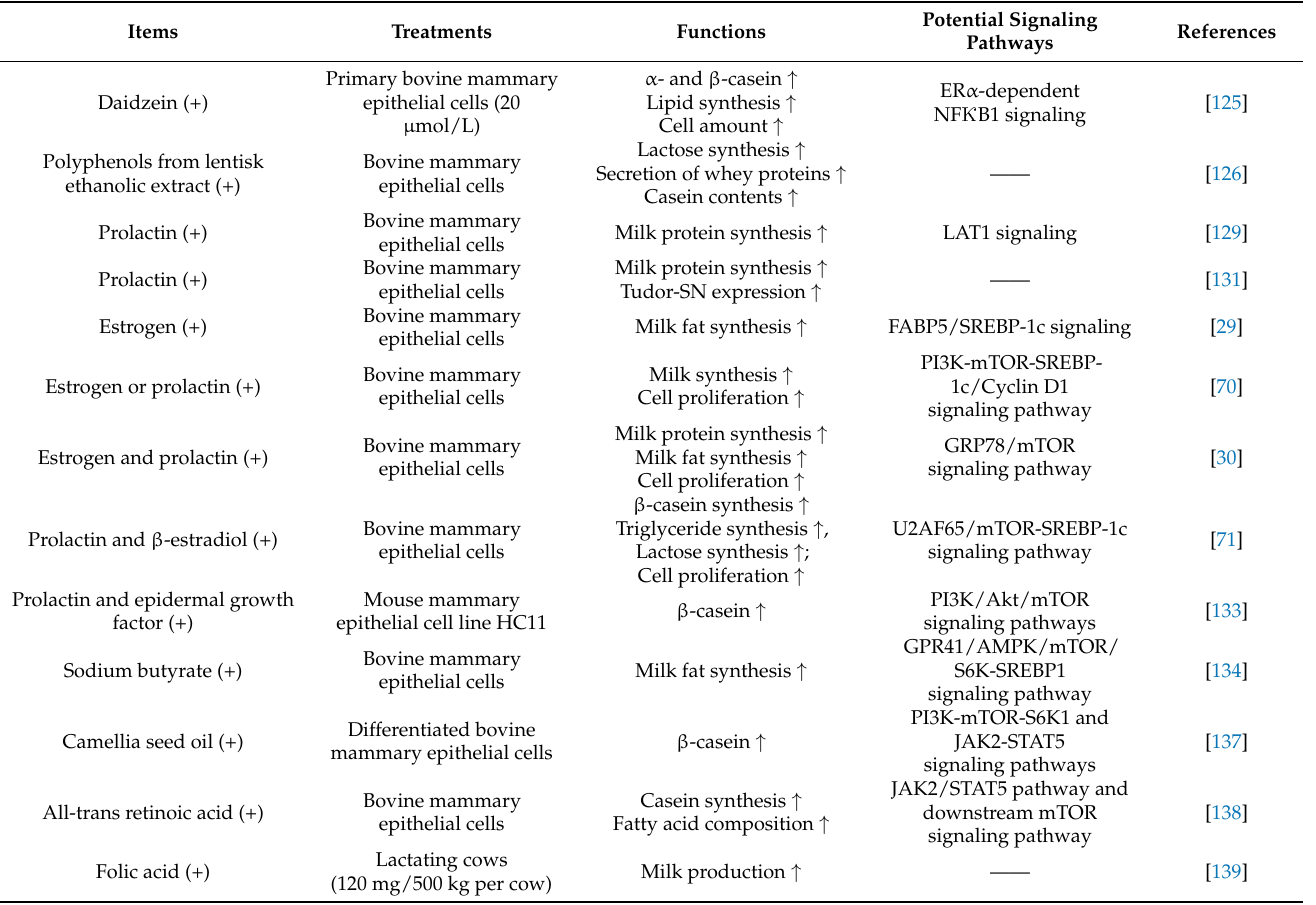
Table 5. Effects of other chemicals on milk production and its potential signaling